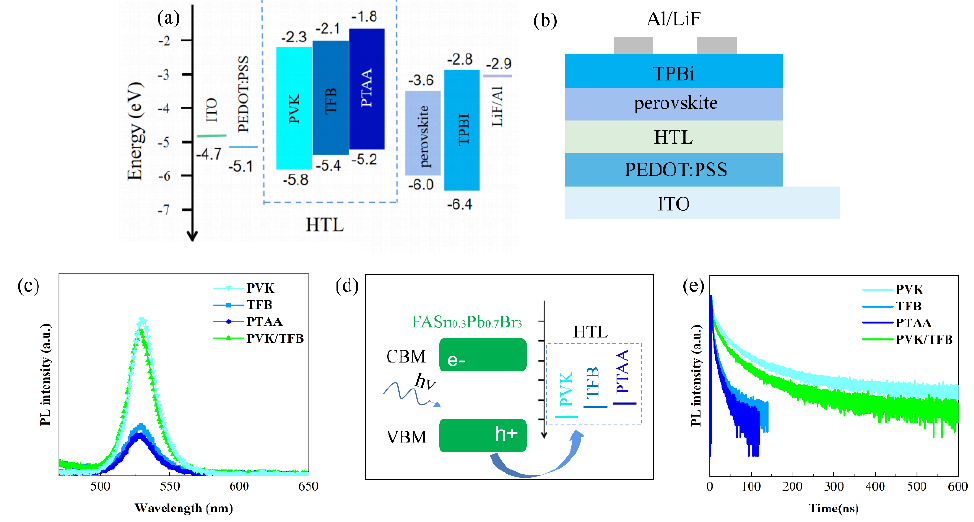
Figure 4. ( a ) Energy − level diagram and ( b ) schematic diagram of single HTL PeLEDs. ( c ) PL intensities, ( d ) Charge transfer model and ( e ) Transient photoluminescence (TRPL) spectra of the FAPb 0.7 Sn 0.3 Br 3 perovskite films coated on the top of PVK, TFB, PTAA, and TFB/PVK, respectively.